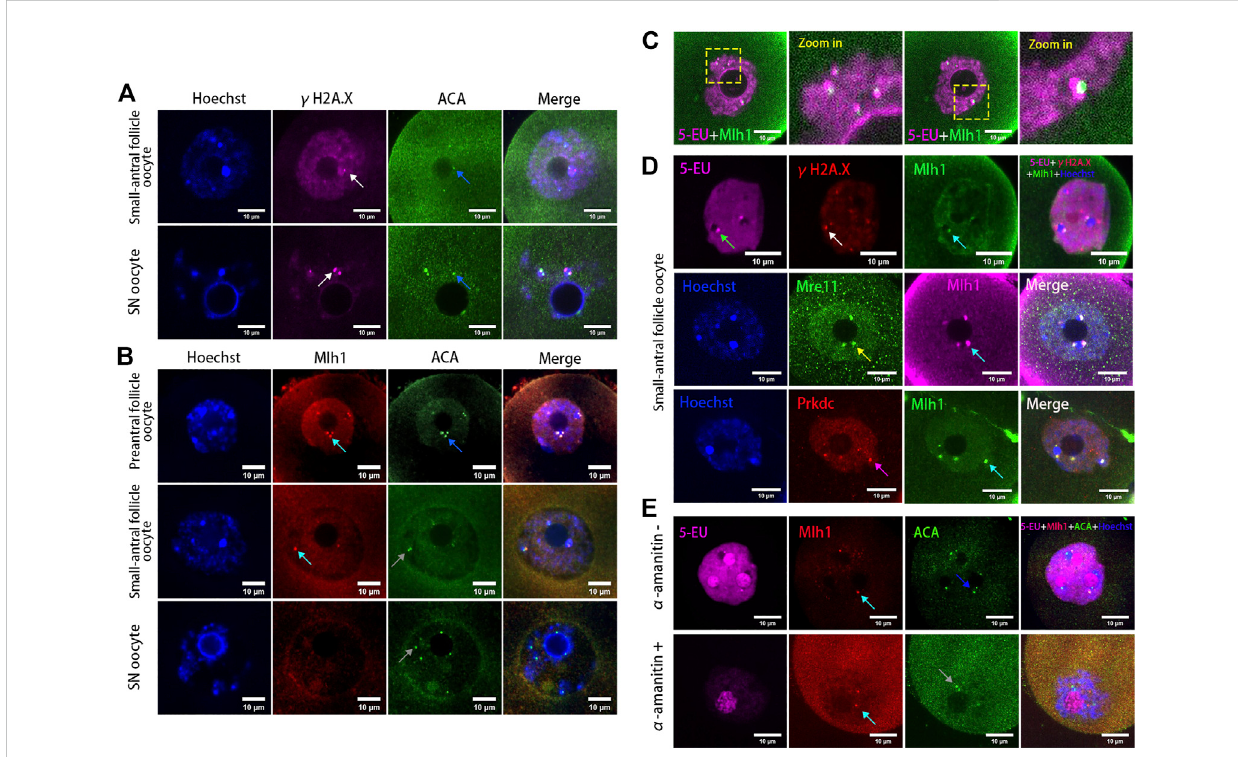
DNA repair proteins associated with centromeres in oocytes. (A) Minor centromeres (ACA) are not colocalized or fully overlapped with the DNA double-strand break marker γ H2A.X foci. (B) Mlh1 (cyan arrows) colocalized with minor satellites (marked by ACA) whereas minor satellites (grey arrows) are not all colocalized with Mlh1, especially in SN oocytes (grey arrows). (C) Mlh1 foci in growing oocytes are associated with the centromeric RNAs. (D) Mlh1 foci colocalized with Mre11 and Prkdc, but not with γ H2A.X foci in growing oocytes. (E) α -amanitin treatment induces the separation of Mlh1 foci from centromeres. Minor satellites, blue arrows; Mlh1, cyan arrows; centromeric RNAs, green arrow; Mre11 focus, yellow arrow; Prkdc focus, magenta arrow; released Mlh1 focus, red arrow; scale bars, 10 μ m. DNA are stained by Hoechst